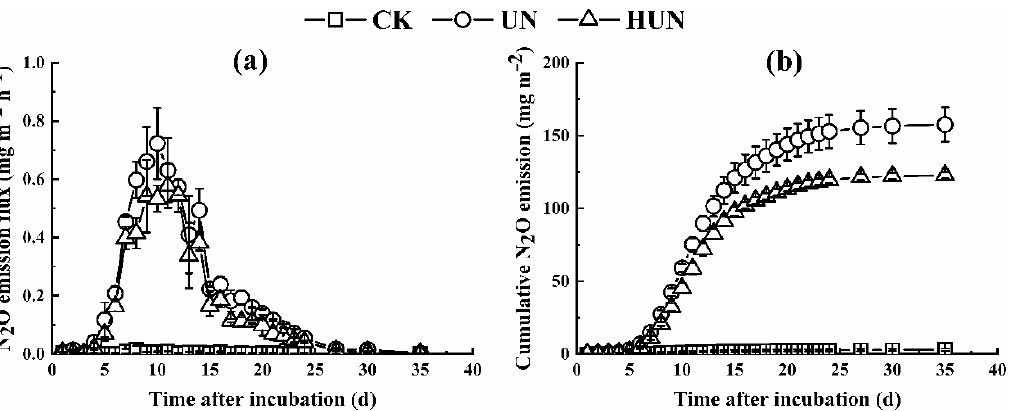
Figure 4. Effects of different treatments on N 2 O emission flux ( a ) and cumulative N 2 O emission ( b ). The vertical coordinate corresponding to the point is the average value. The length of the error bars is the standard deviation. N 2 O: nitrous oxide, CK: no nitrogen, UN: urea at 240 kg N hm − 2 , HUN: humic acid urea at 240 kg N hm − 2 . Table 1. The effects of different treatments on nitrogen loss in nitrogen